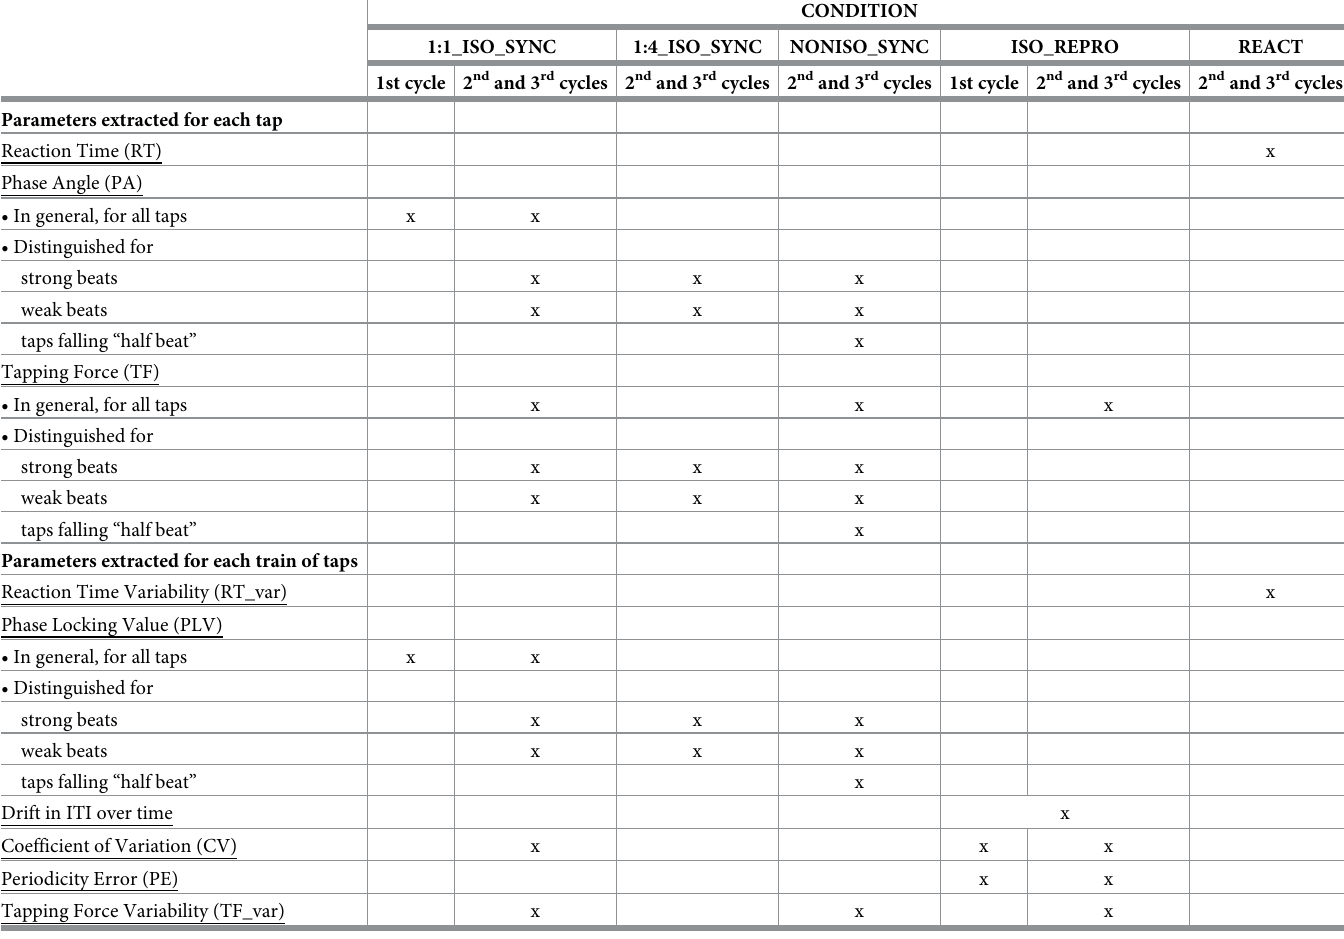
Table 2. Summary of the seven descriptors considered in this study, depending on the